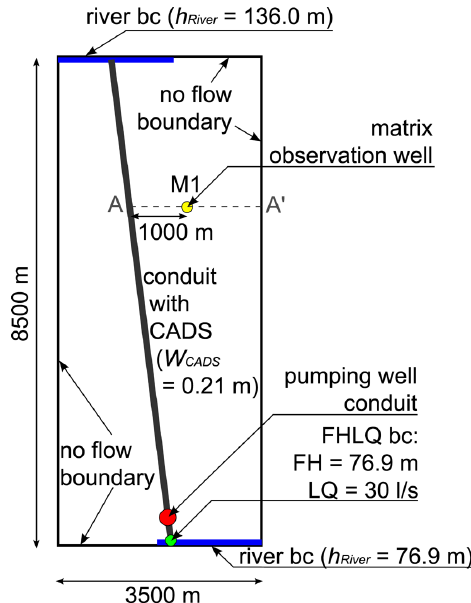
Fig. 9. Conceptual representation of the large-scale pumping test scenario at the Cent Fonts karst